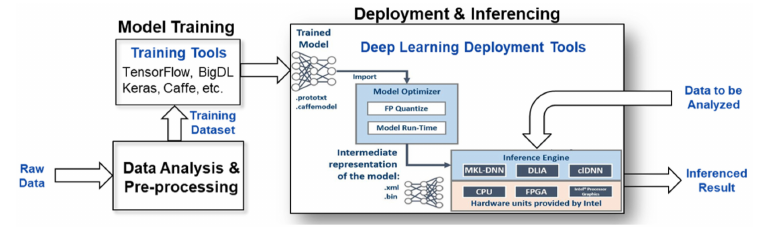
Figure 1: Heterogeneous computing workflow for machine